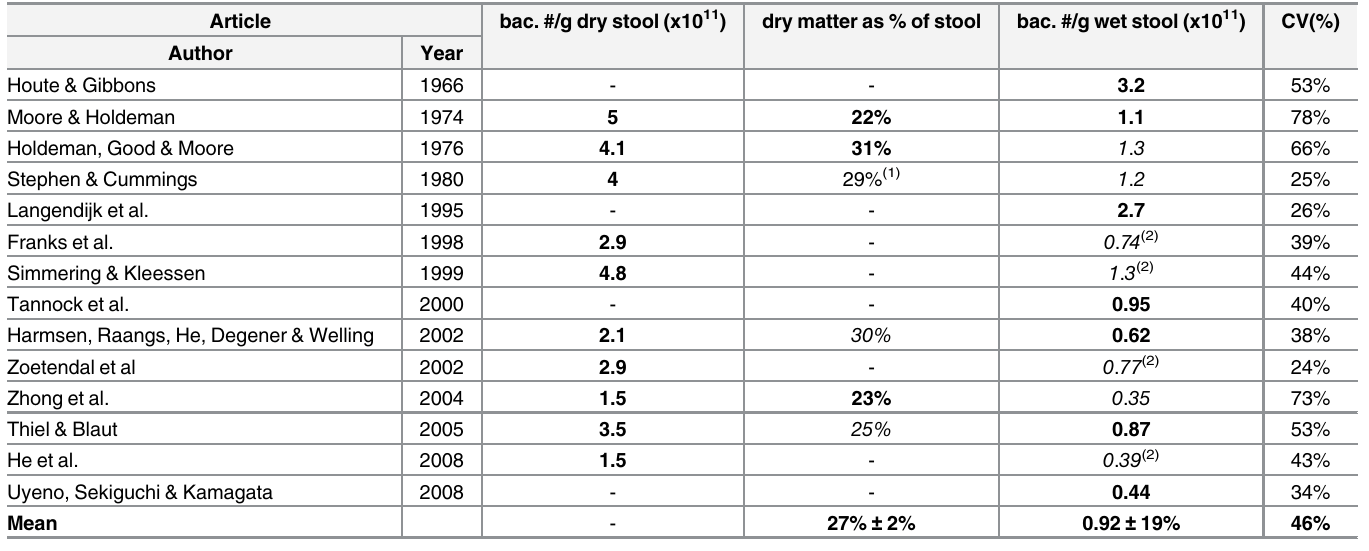
Table 2. Values of bacteria density in stool as reported in several past